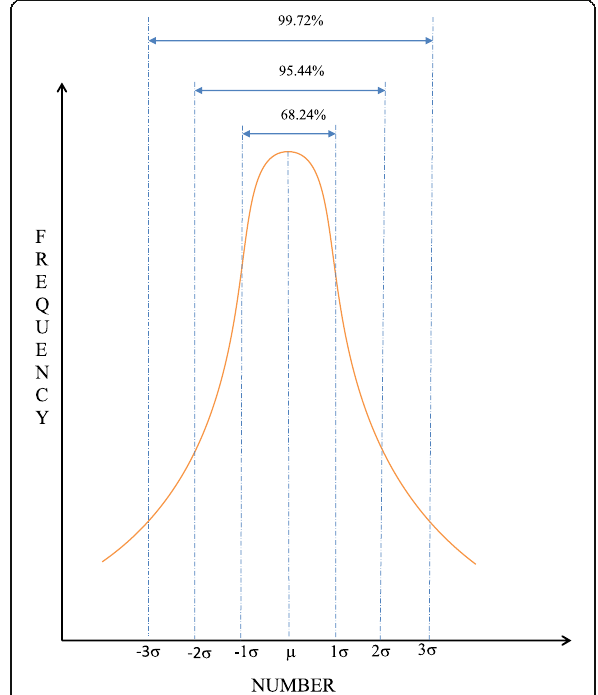
Fig. 1 Standard deviation as a measure of dispersion. Legends: σ , standard deviation; μ ,